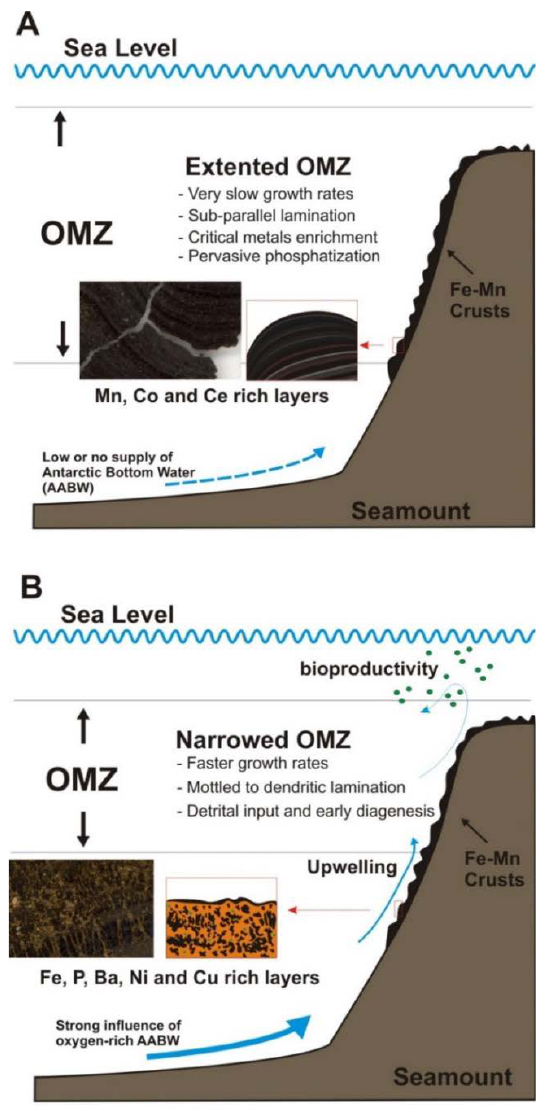
Figure 14. Model of the formation of Fe–Mn crusts in the CISP with textural features and metal enrichment characteristics. ( A ) periods of extended OMZ lead to the formation of sub-parallel lamination with low growth rates. ( B ) periods of narrowed OMZ lead to the formation of dendritic to mottled laminations with high growth rates. See the text for further explanation.